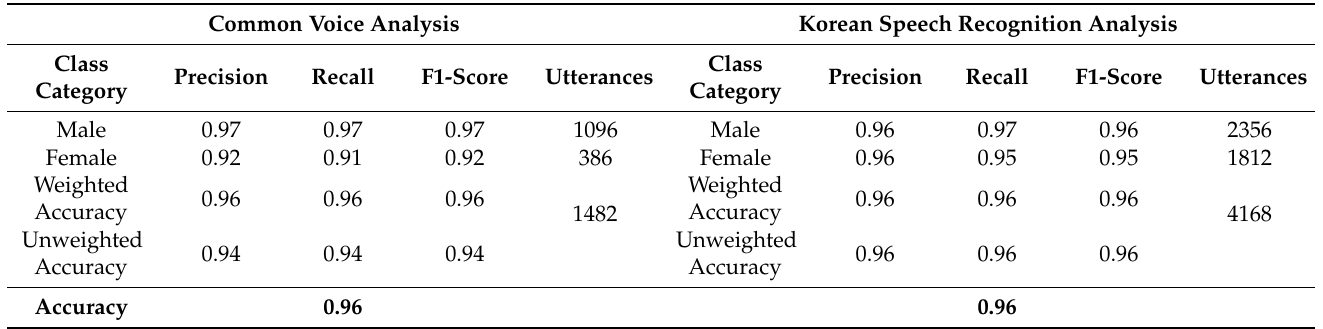
Table 8. Classification report of the proposed gender classification model for each dataset presents the precision, recall, F1-score, and weighted and unweighted accuracy results. Numbers with bold fonts indicate the average classification accuracy.